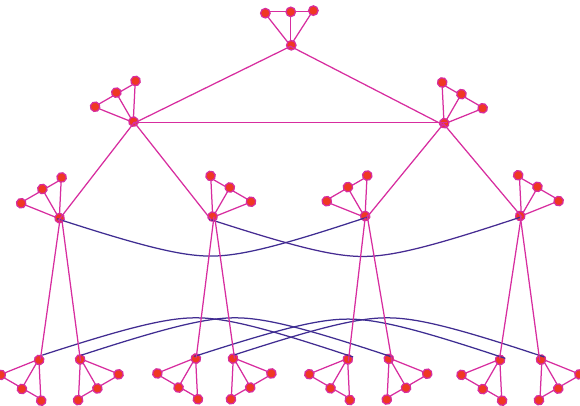
Figure 2: Depiction of corona product of complete hypertree and path CBT ( 3 ) ⊙ P Table 5: Edge partition of CBT ( t ) ⊙ P n grounded on eccentricity of end vertices of every edge, ( ϱ ( l ) , ϱ ( m )) Range of t and k